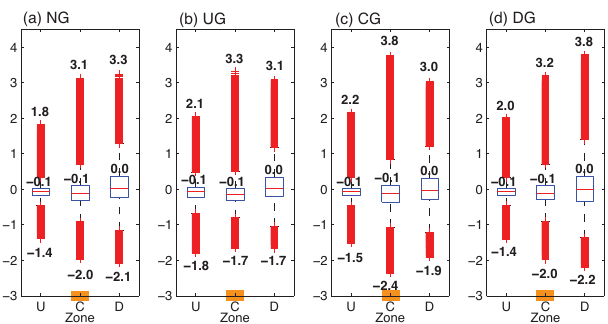
Figure 9. As in Fig. 8 but for vertical velocity (ms − 1 ).